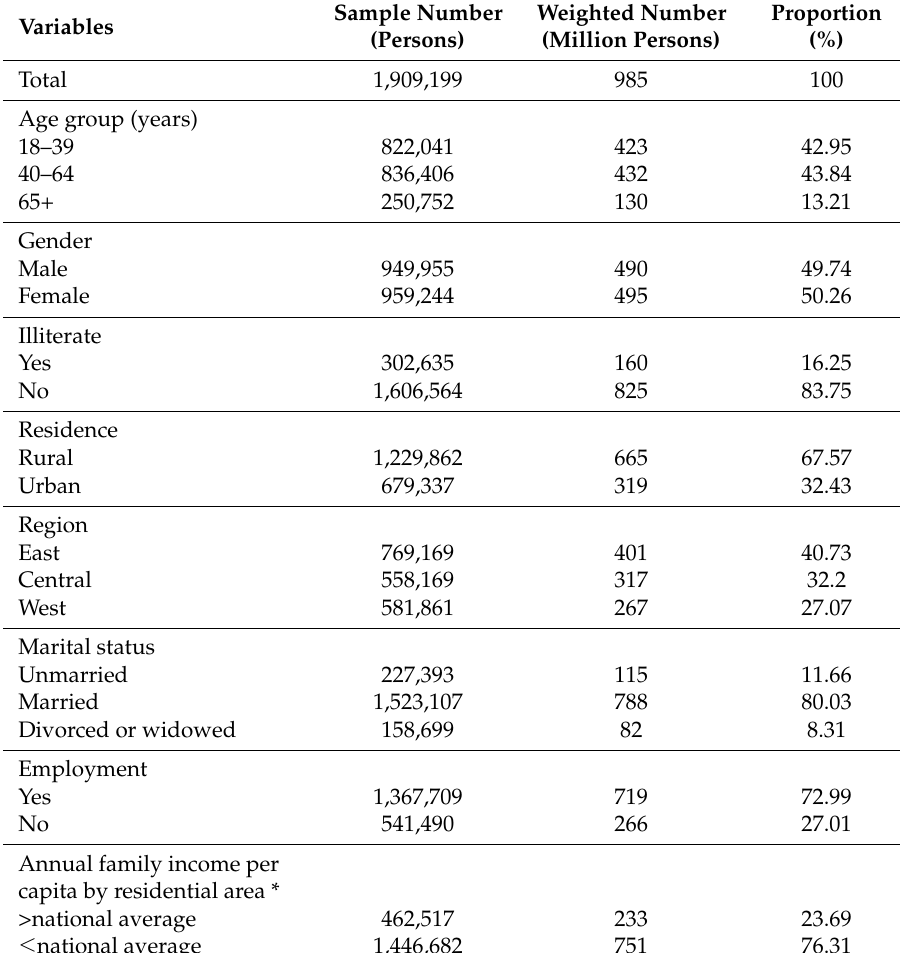
Table 1. Participants